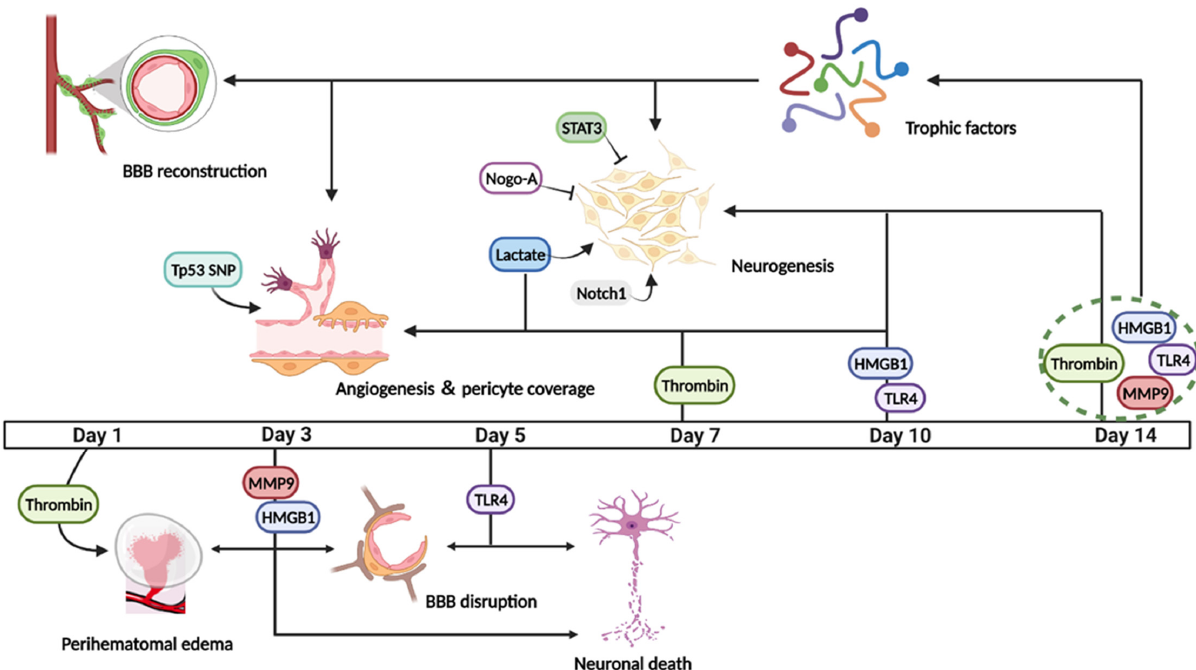
Figure 2. Some molecules including thrombin, MMP-9, HMGB1, TLR4, show divergent effects on post-ICH repair. They tend towards causing pathological changes such as brain edema, BBB disruption, neuronal degeneration, or death in the early phase after ICH, but convert to beneficial regenerative processes by increasing DCX+ cells, promoting endothelial proliferation, pericyte coverage, and stimulating trophic factors at the later stage after ICH. Moreover, the expression of STAT3 and Nogo-A after experimental ICH is observed to inhibit neurogenesis, while Notch1 and the generation of lactate can promote this process.